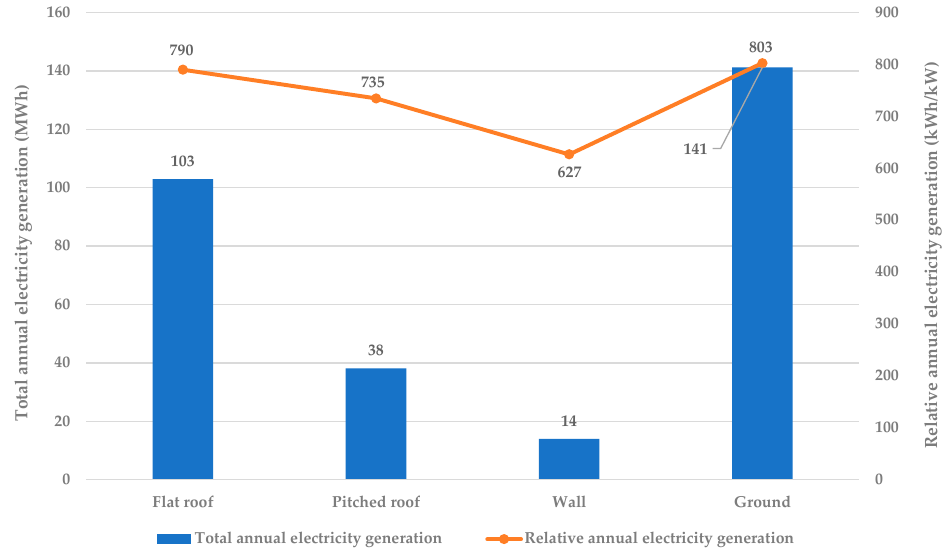
Figure 6. Annual electricity production by PV modules for each analyzed object.